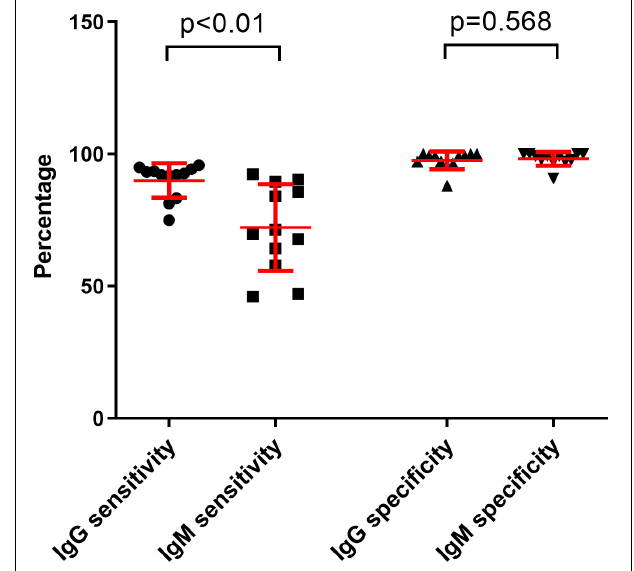
FIGURE 3 | Comparing the differences between IgG sensitivity and IgM sensitivity or between IgG specificity and IgM specificity with different reagents. Data were expressed as mean and standard